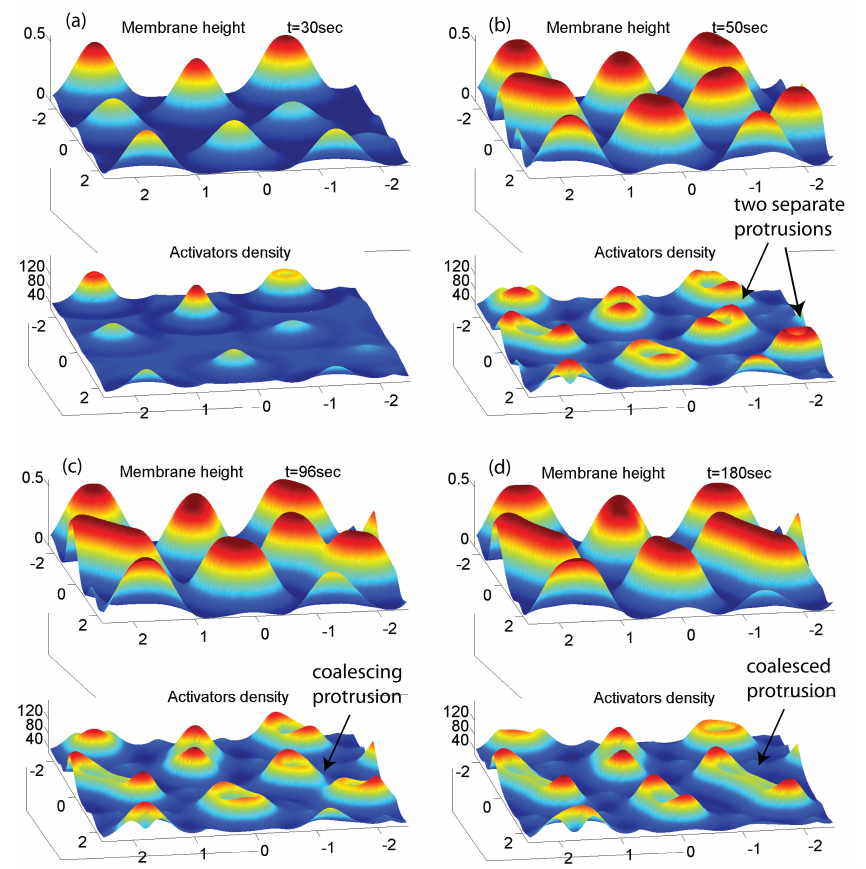
Figure 5. Simulation over a period of 3 min over a membrane segment of size 5 × 5 µ m 2 , with Gaussian noise in the initial membrane height with variance of 10nm. The membrane’s random initial deformations develop into protrusions of lateral size ∼ λ c . ( a ) the initial growth period before most of them make contact with the substrate. ( b , c ) the stabilization period of the protrusions, which elongate into the available space and may coalesce with very proximal protrusions. ( d ) the final steady state of the system. We used the same parameter values as in Figure